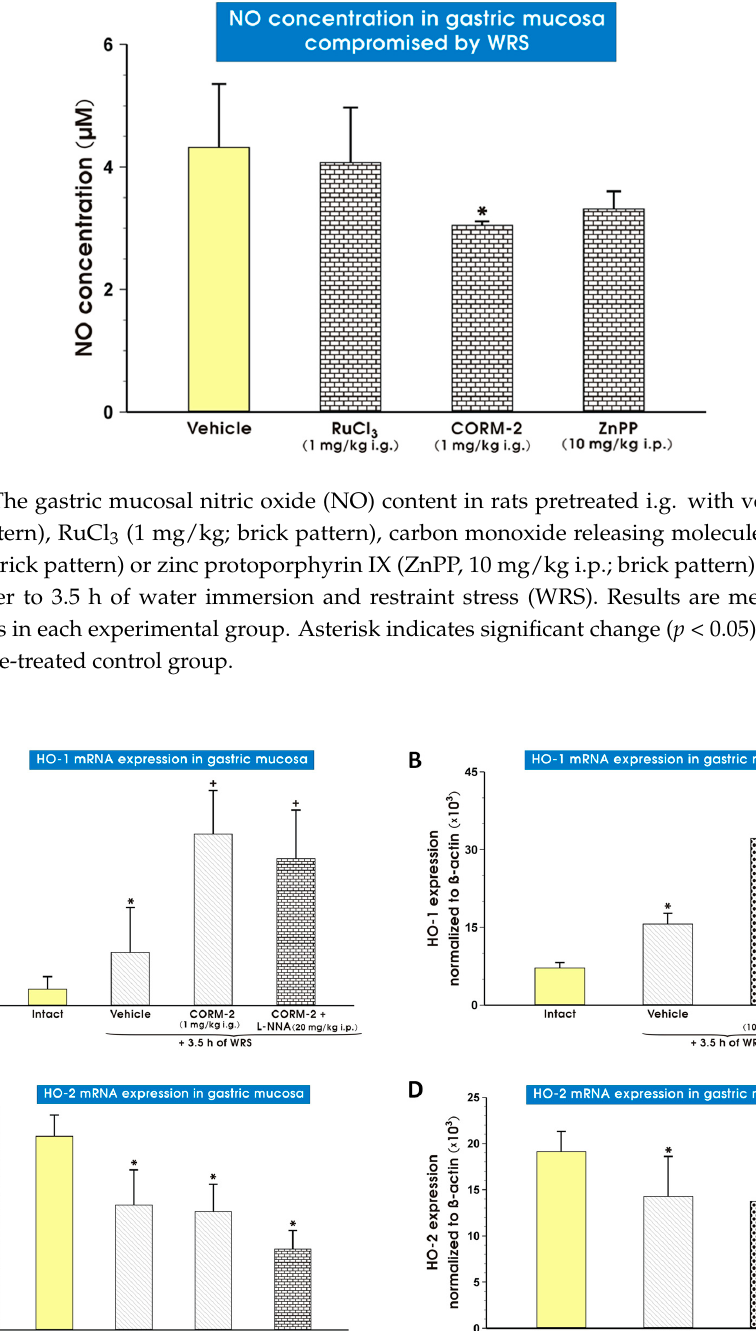
Figure 9. Expression levels of mRNA for heme oxygenase (HO)-1 ( A , B ) and HO-2 ( C , D ) in the gastric mucosa of intact rats (yellow pattern) or those pretreated with vehicle (saline; i.g.; line pattern), hemin (10 mg/kg i.g.; dot pattern) or carbon monoxide releasing molecule 2 (CORM-2, 1 mg/kg i.g.) alone (line pattern) or administered in combination with N G -nitro- L -arginine ( L -NNA, 20 mg/kg i.p.; brick pattern) and exposed to 3.5 h of water immersion and restraint stress (WRS). Results are expressed as mRNA expression of HO-1 and HO-2 normalized to β -actin. Results are mean ± S.D. of 6–8 determinations per group. Asterisk indicates a significant change ( p < 0.05) as compared with the respective values in intact gastric mucosa. Cross indicates significant change ( p < 0.05) as compared with the values obtained for the vehicle-treated group.